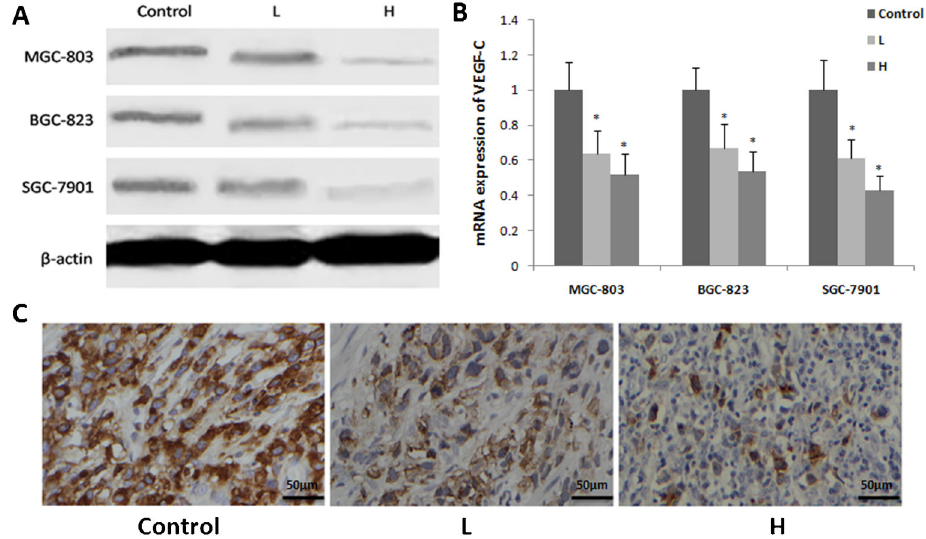
Figure 1. Vascular endothelial growth factor-C (VEGF-C) expression was downregulated after S-adenosylmethionine (SAM) treatment. A , Western blot analysis of VEGF-C protein level in gastric cancer cells. L: 2 mM SAM; H: 4 mM SAM. B , RT-qPCR analysis of VEGF-C mRNA level in gastric cancer cells. *P , 0.05 vs control. L: 2 mM SAM; H: 4 mM SAM. C , Immunohistochemical analysis of VEGF-C expression in MGC-803 tumor xenografts. L: 192 m mol ? kg –1 ? day –1 SAM; H: 768 m mol ? kg –1 ? day –1